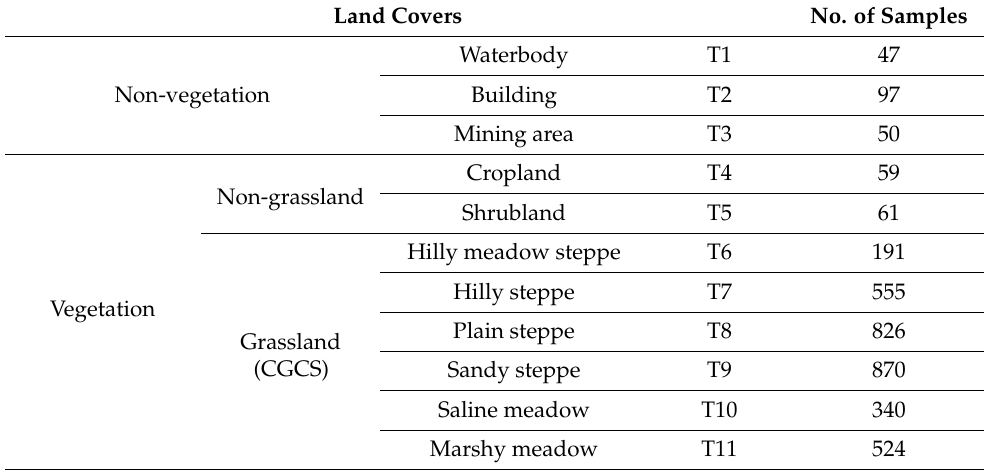
Table 1. Classification system and sample